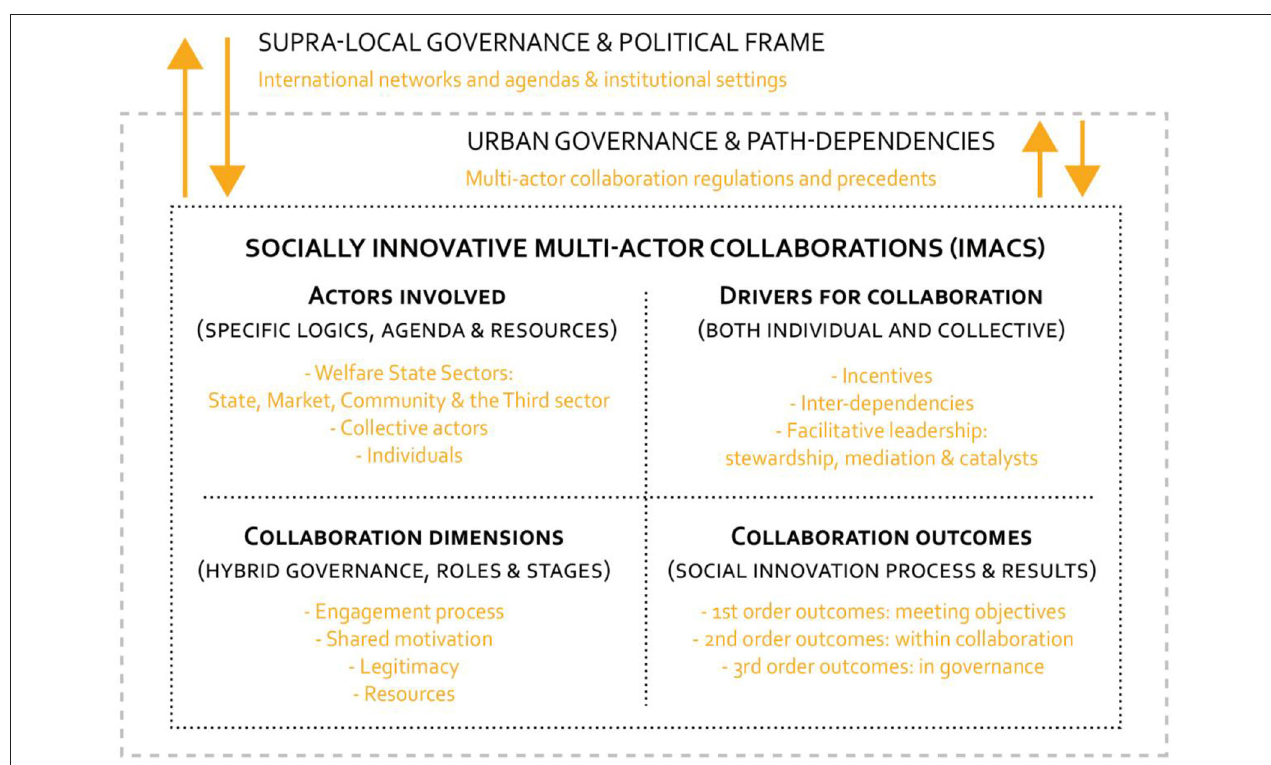
FIGURE 1 | Summary of multi-level governance inter-relations and internal dimensions of IMACs guiding our research. (Source: authors’ elaboration inspired by literature from social innovation, collaborative governance, and facilitative leadership).